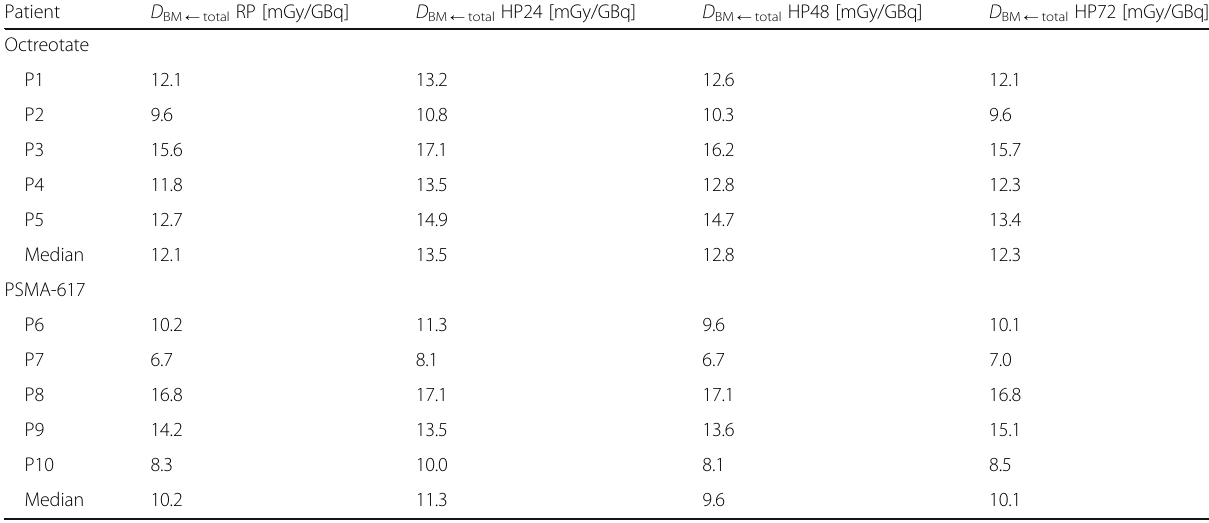
Table 4 Comparison of the reference and hybrid protocol for different time points of single whole-body planar image acquisition